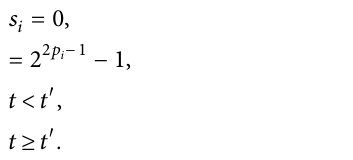
Table 2: Frequencies and expected frequencies of possible geno- types, formed by two alleles A Hardy-Weinberg equilibrium.